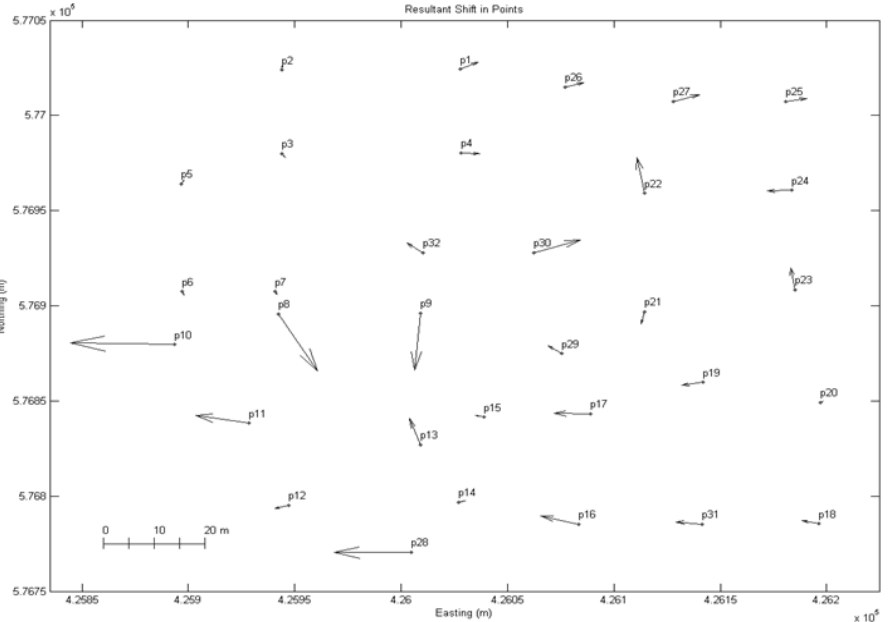
Figure 4. Magnitude and direction of mismatches between Ordnance Survey (OS) and OpenStreetMap (OSM) data, Cramlington,